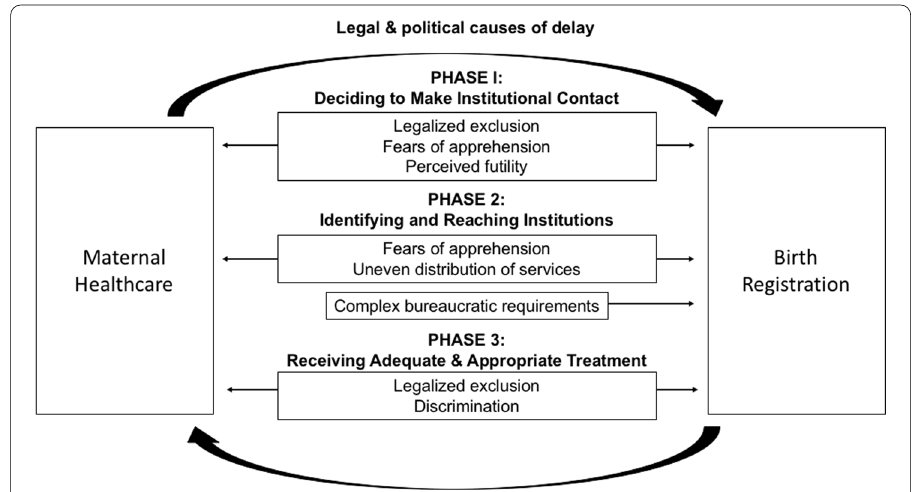
Fig. 3 The integrated three delays